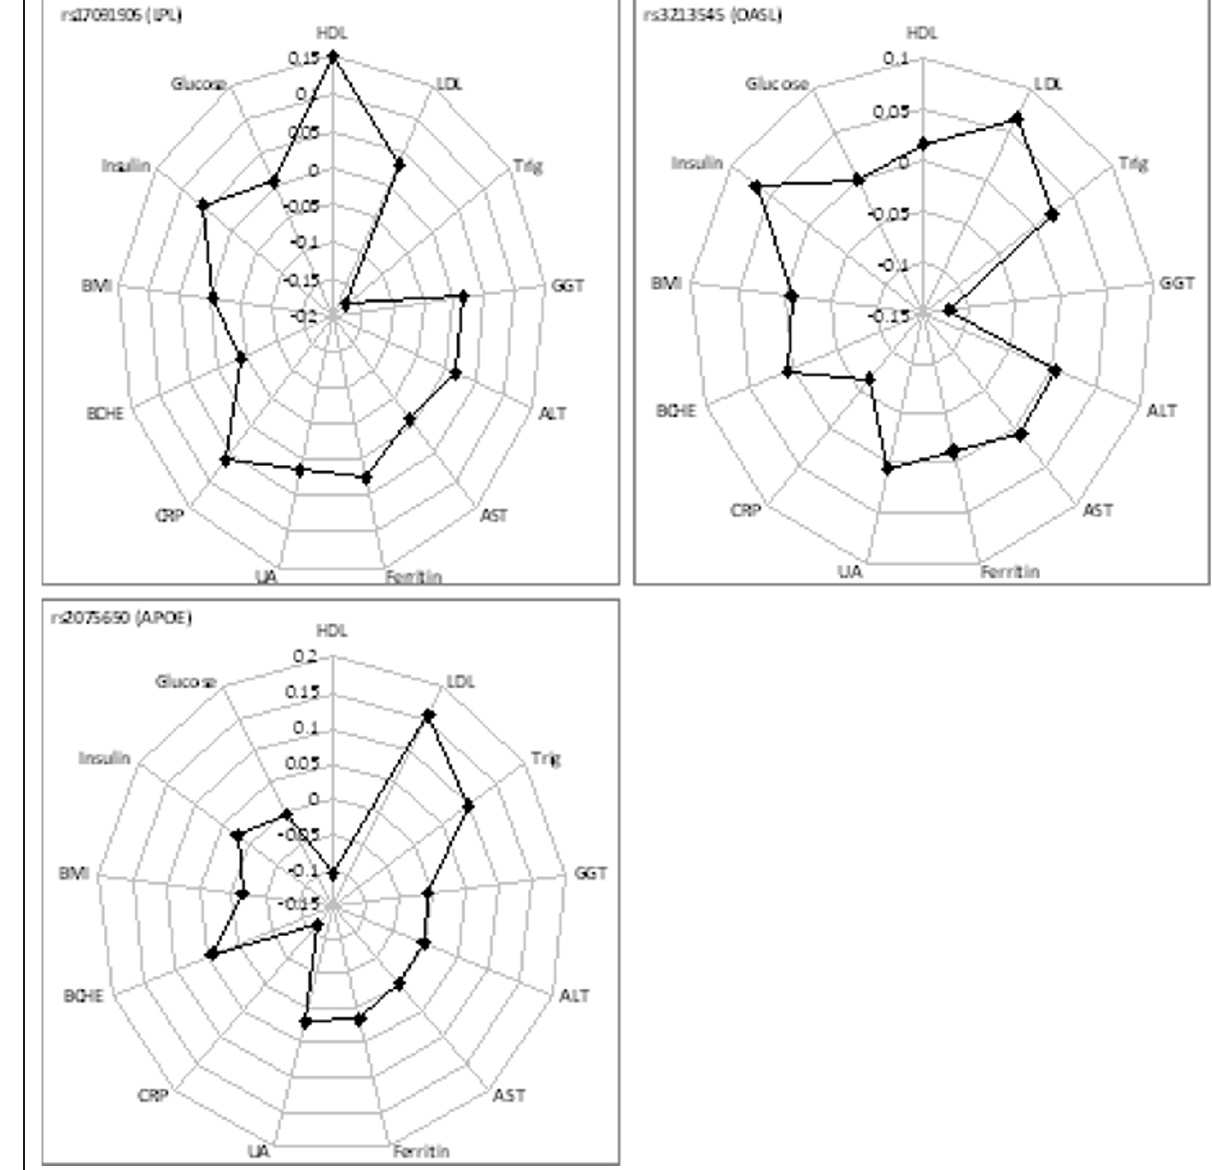
Figure 2 Radar chart of polymorphisms on chromosome8 (a), chromosome 12 (b) and chromosome 19 (c) . Each dot on the plot represents the standardized beta (1-unit change per copy increment of the minor allele) of each trait from univariate